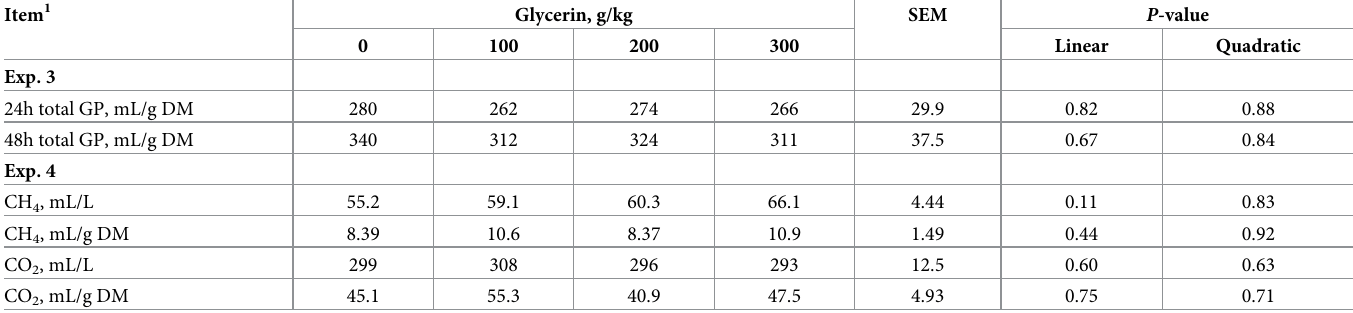
Table 4. Effects of dietary glycerin inclusion on total gas production (GP), and enteric methane (CH 4 ) and carbon dioxide (CO 2 ) production in GP systems. Item